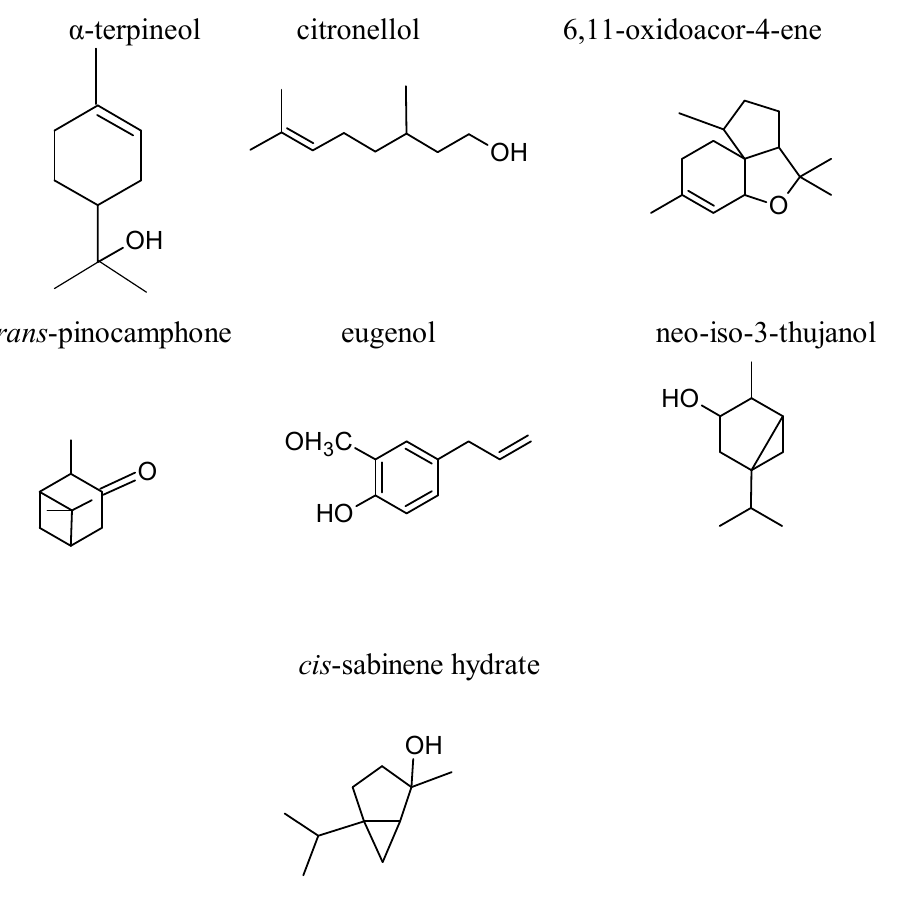
Figure 2. Structures of some terpenoid